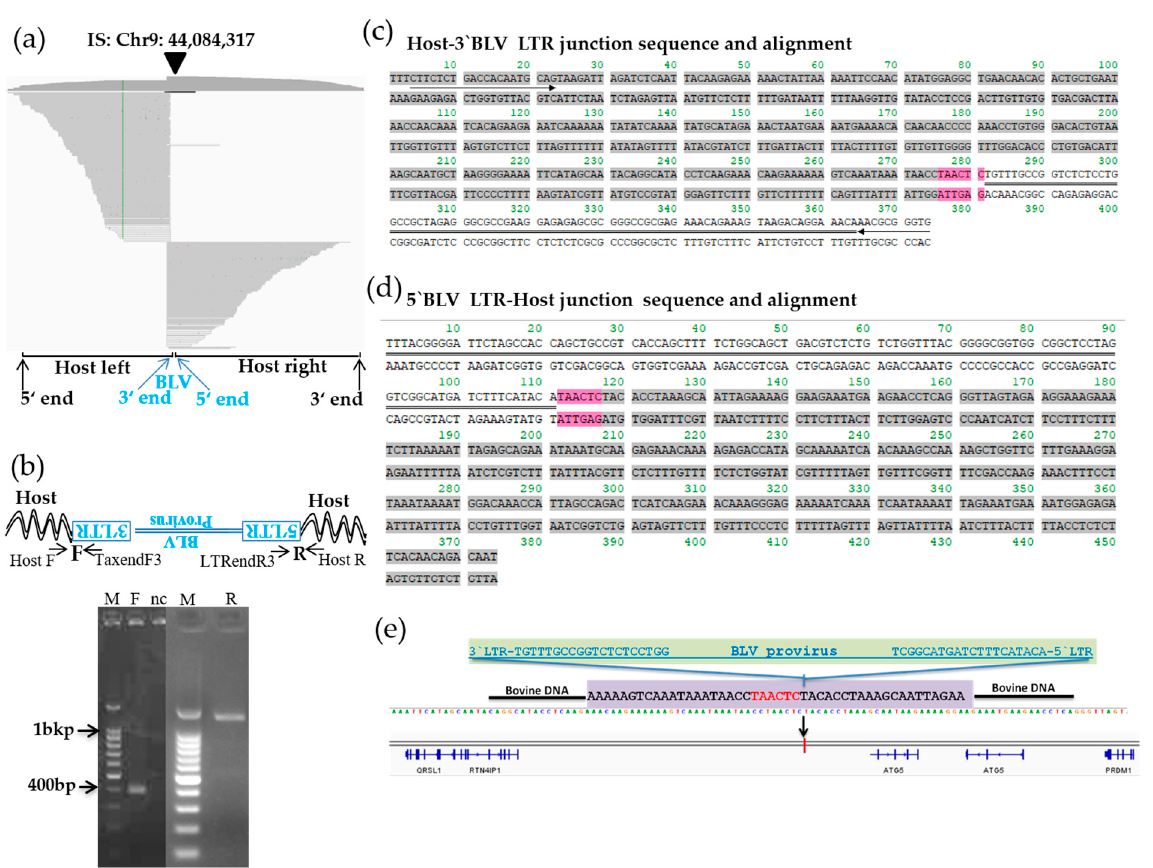
Figure 6. Visualization of next-generation sequencing (NGS) reads mapped to the bovine genome around integration site of the BLSC-KU17 and confirmation of its provirus integration sites. ( a ) Paired-end reads mapping and visualization of host genome sequences in which the BLV provirus is integrated in BLSC-KU17 cells. The arrow-head indicates the location of the integration site. The sequences of virus–host chimeric reads next to the end of the BLV genome are indicated as host-left and host-right, respectively. ( b ) Confirmation of the detected integration site by electrophoresis of the PCR amplicon. Arrow indicates forward (F) and reverse (R) primer binding sites corresponding to cattle and BLV proviral sequences. M, molecular weight marker (100-bp DNA Ladder); nc, no- template DNA-negative control (water substituted for DNA template). ( c , d ) Sequence result of host– 3 ′ -BLV LTR ( c ) and 5 ′ -BLV LTR–host ( d ) junction DNA in BLSC-KU17 cells. Arrow indicates the primer binding site. Sequences in gray color indicate host cattle genome; sequences with double line indicate the BLV provirus sequence; 6 bp nucleotide sequences colored in pink indicate duplicated host cattle sequences. ( e ) Schematic presentation of the BLV integration site in BLSC-KU17 cells.